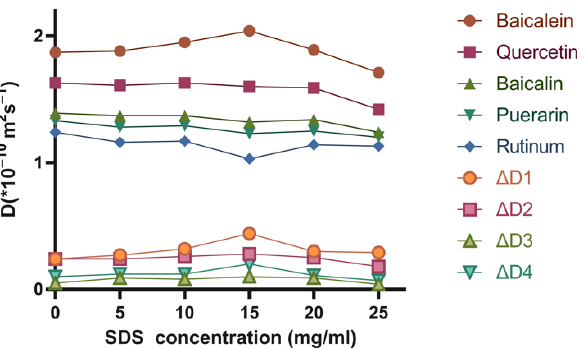
Figure 4. Effects of different SDS concentrations on the diffusion coefficient (D) and resolution ( ∆ D) of each analyte in the flavonoid mixture model. Matrix (3 mg, 6 mg, 9 mg, 12 mg, 15 mg) and mixture models (3 mg for each analyte) were dissolved in 600 µ L of DMSO–d6 solution.